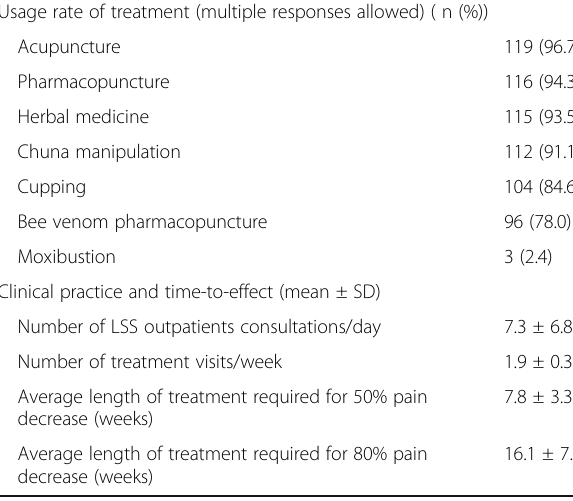
Table 2 Clinical practice patterns of LSS Usage rate of treatment (multiple responses allowed) ( n (%))